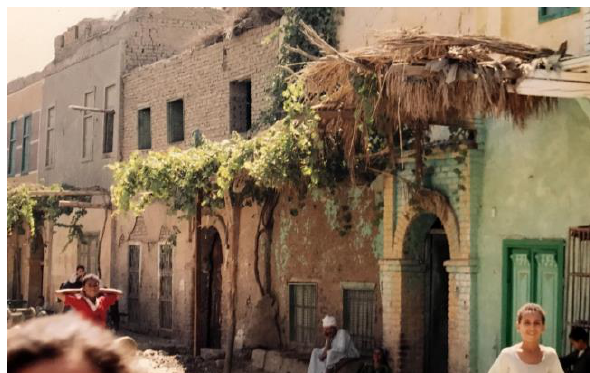
Figure 4. Two-story building, mud brick vernacular architecture